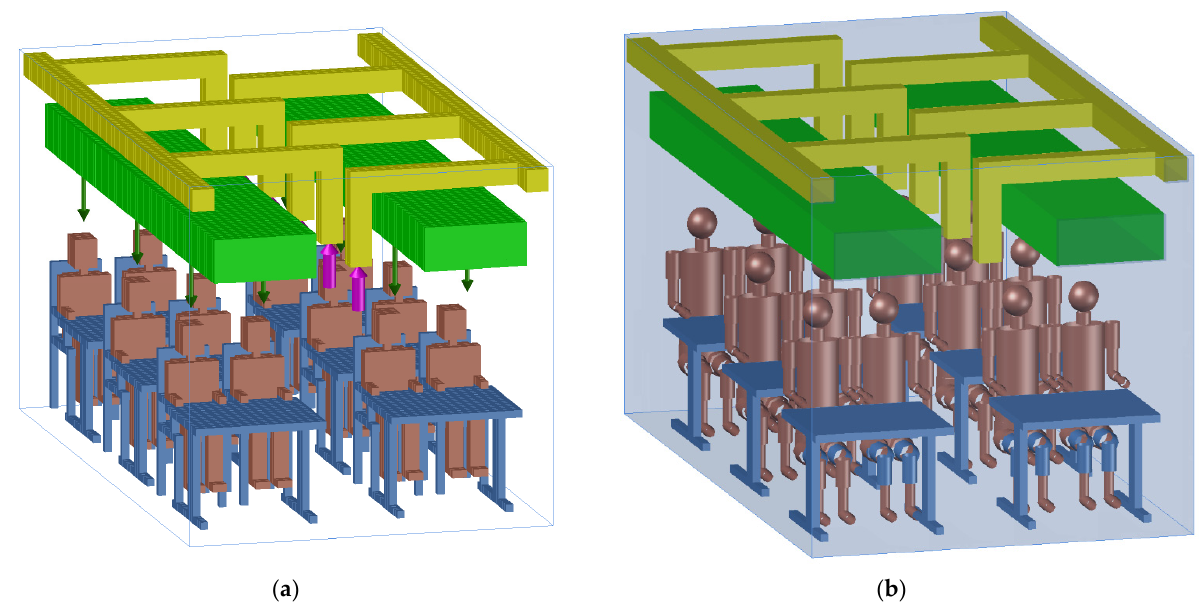
Figure 3. Scheme of the virtual chamber, equipped with ceiling-mounted localized air distribution and exhaust systems used in the: ( a ) CFD model; ( b ) HTR model. The occupants are brown; desks and seats are blue; inlet ceiling-mounted localized air distribution system is green; inlet jet airflow is represented by green arrows; exhaust ventilation systems are represented by yellow; and outlet jet airflow is represented by magenta arrows.